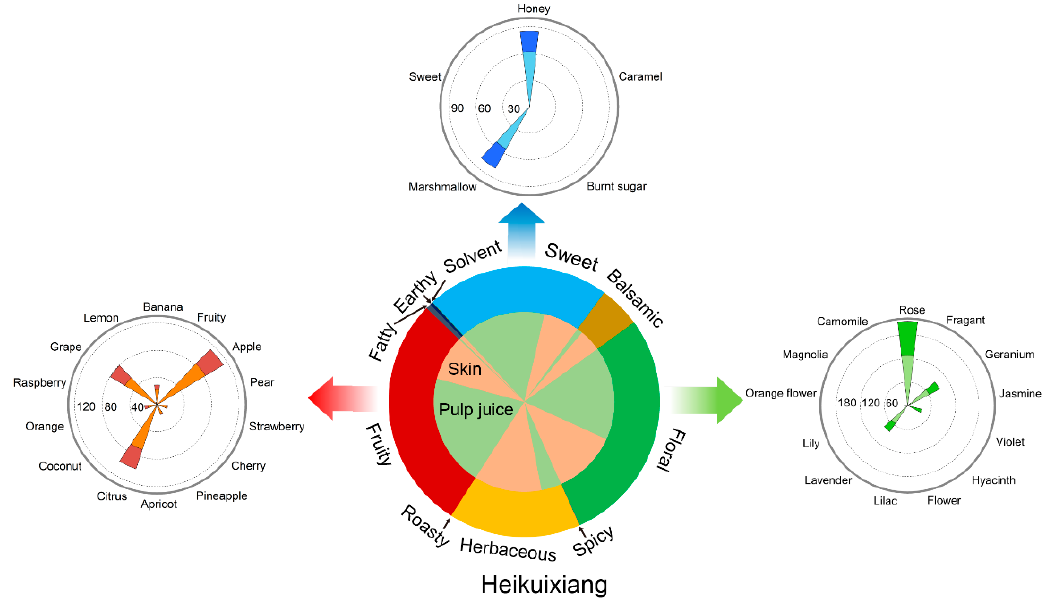
Figure 4. Aromatic fingerprints of Heikuixiang. In the central pie chart, the outer band represents the primary aromatic series, while the interior band represents the berry components—skin (orange) and pulp juice (green). The concentric circles to the left, right, and top of the pie chart represent the fruity, floral, and sweet secondary aromatic series, respectively. In these circles, the outer radial sectors (deep colors) represent the skin, and the inner sectors (light colors) represent pulp juice.